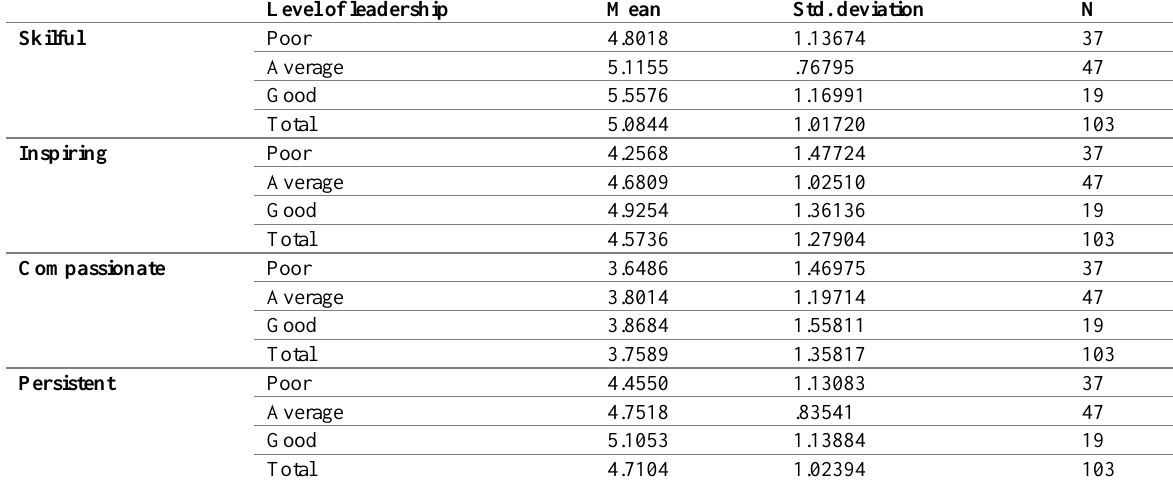
Table 7: Descriptive statistics across levels of leadership